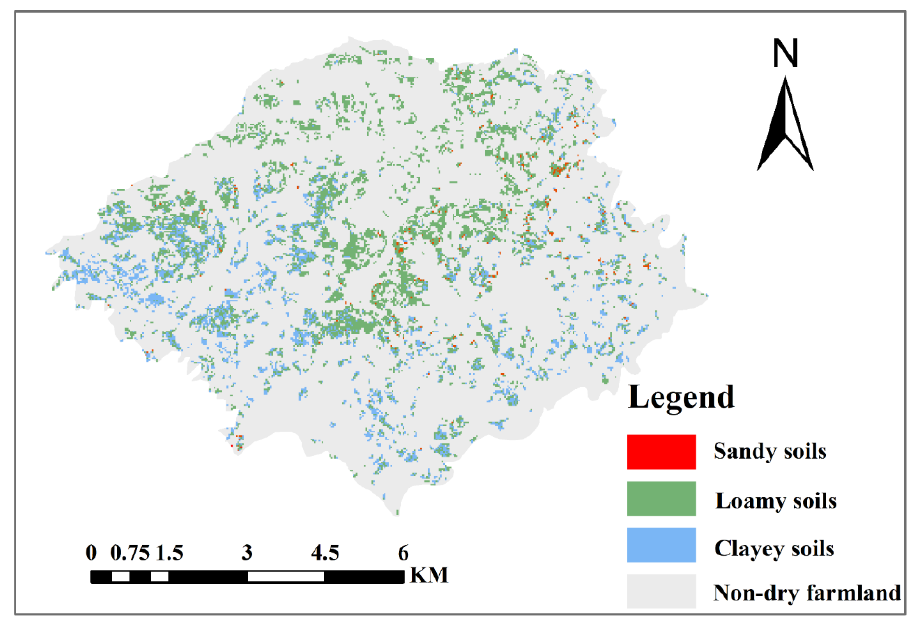
Figure 9. Soil classification map.